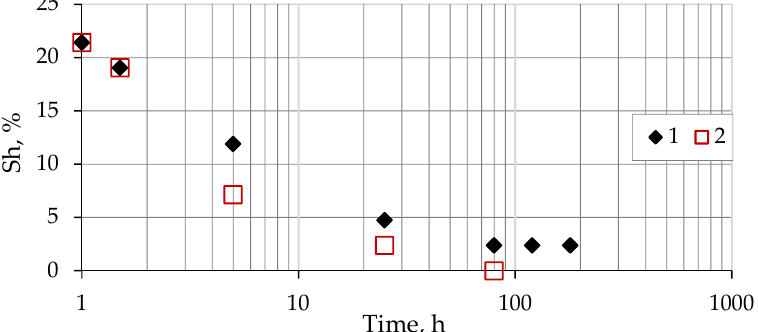
Figure 5. Time-dependent changes in the methane hydrate ( S h ) saturation of sand 1 with 3% of montmorillonite clay (W = 10%) after the pressure dropped to 0.1 MPa: not cooled (1) and cooled (2) in liquid N 2 .